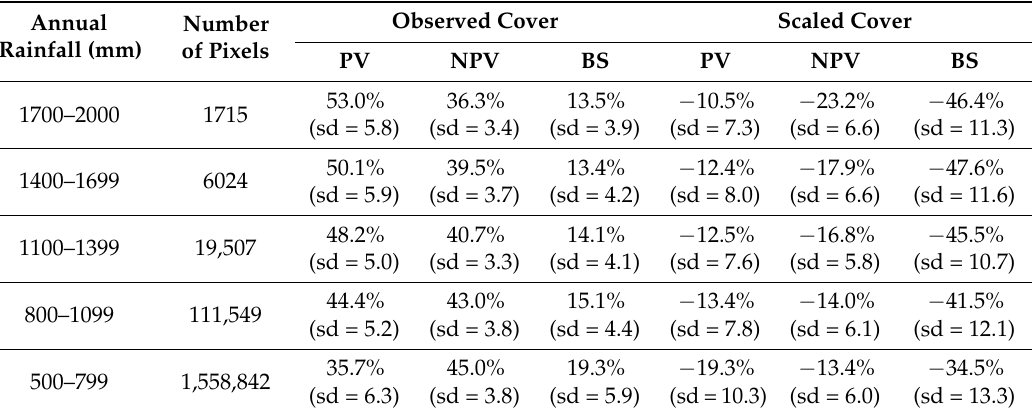
Table 3. Components of fractional cover along a gradient of average annual rainfall. sd—standard deviation.